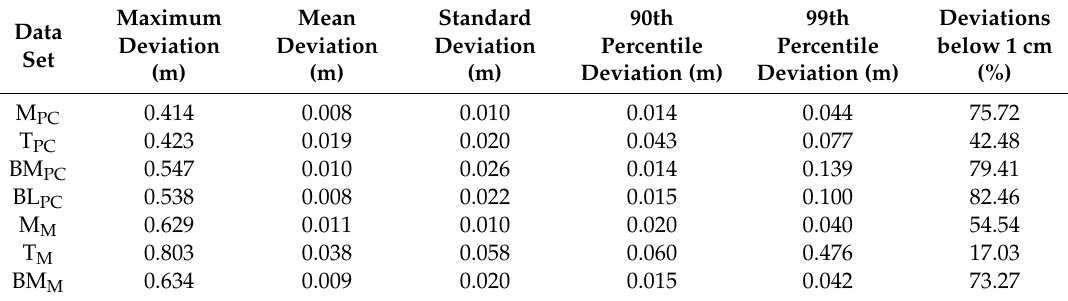
Table 5. Results of the distance analysis of the Tetra room